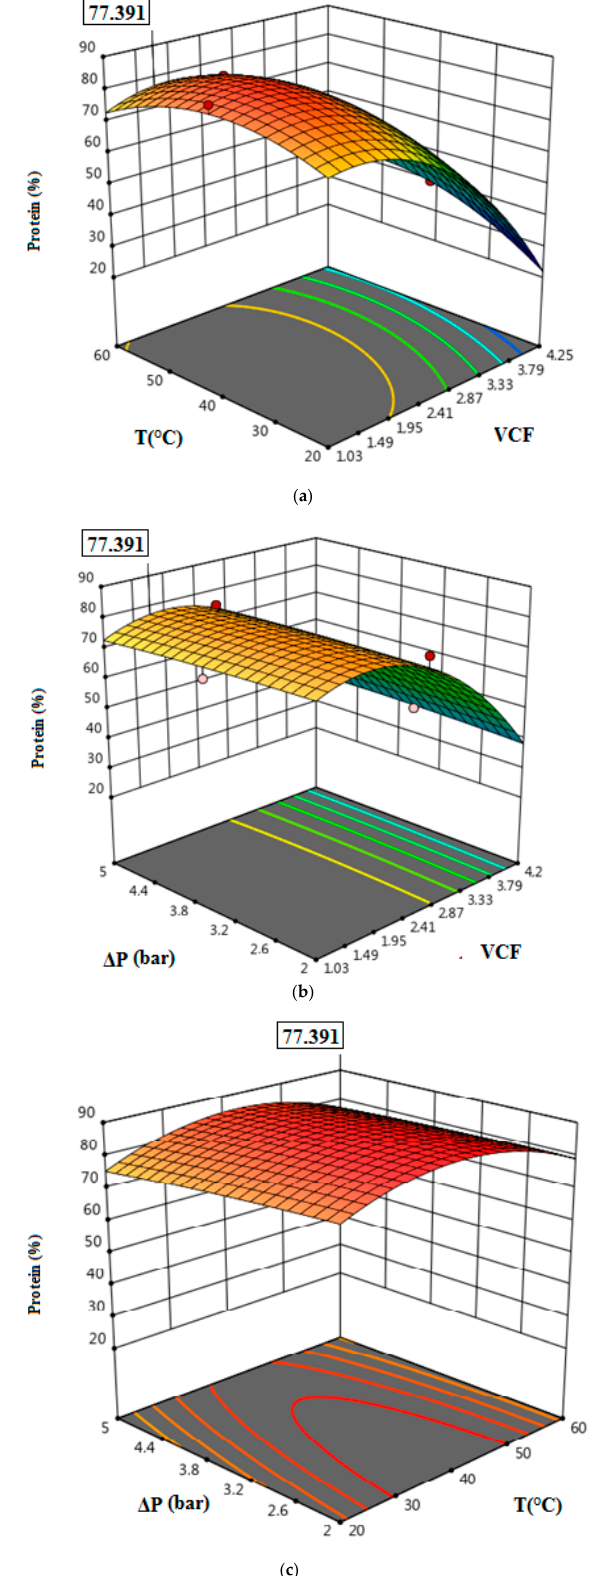
Figure 7. Response surface plots showing the effects of variables on protein removal: The interac- tion of VCF and T ( a ); the interaction of VCF and Δ P ( b ); the interaction of T and Δ P ( c ).